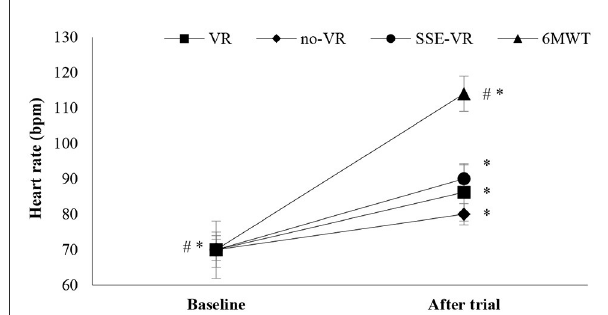
FIGURE2 Heart rate changes between trials. * p < 0.001 between baseline and trials, # p < 0.05 between trials [virtual reality (VR), exercise using the VR system; no-VR, exercise without using the VR system; SSE-VR, self-selected exercise using the VR system; 6MWT, 6-minute walk